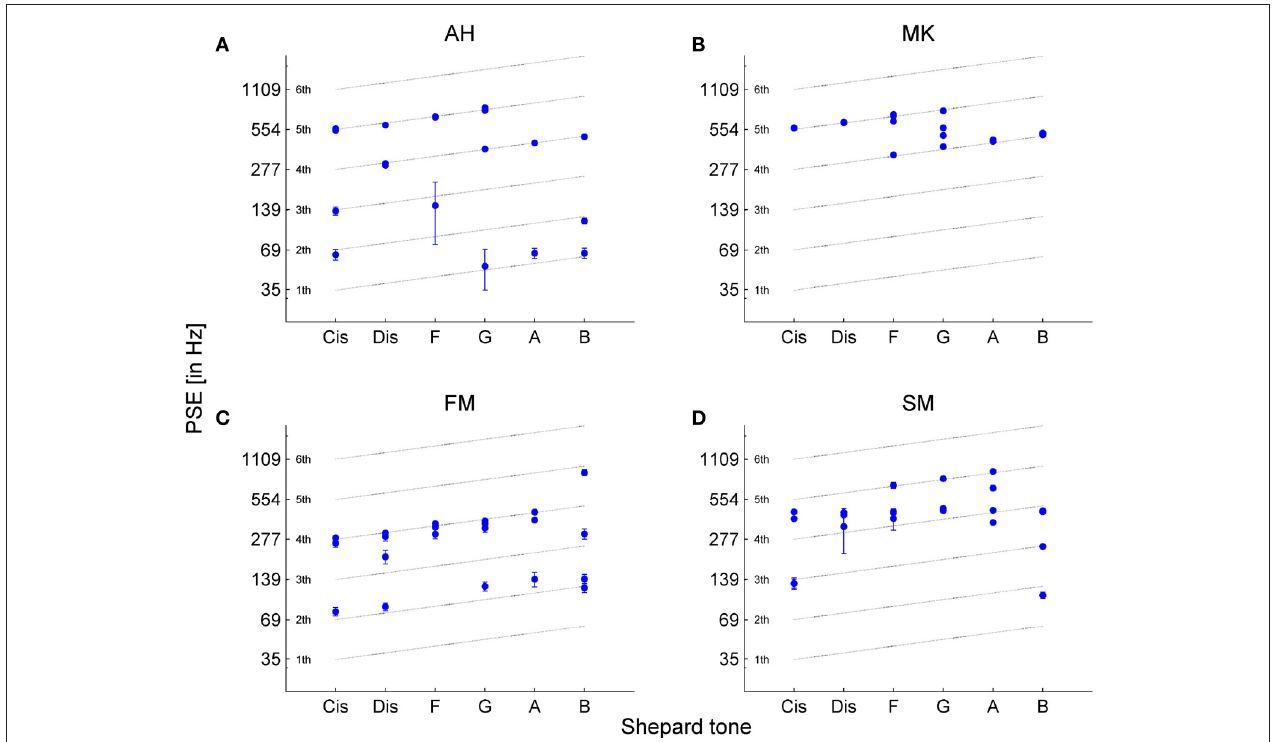
FIGURE 5 | Point of subjective equality (PSE) estimates of the four adaptive sequences for each Shepard tone for (A) participant AH , (B) MK , (C) FM and (D) SM . The PSEs were estimated by the mean of the last four turnpoints in the up-down staircase method. The error bars represent the standard error of the four turnpoints used for PSE estimation. In some cases, standard errors are too small to be visible. There are less than four data points in some cases because of several reasons: the turnpoints were not enough to estimate the PSE, and similar PSE estimates result in overlaid data